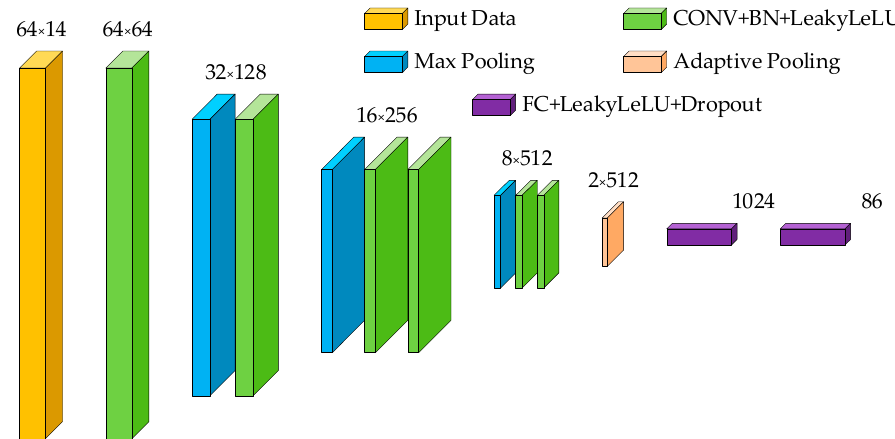
Figure 13. Network structure of the classification model for SLR. This model uses VGG architecture to classify sign language. The input of the model was sign language samples of 14 channels, and the output is a one-hot code vector which the dimension is 86.